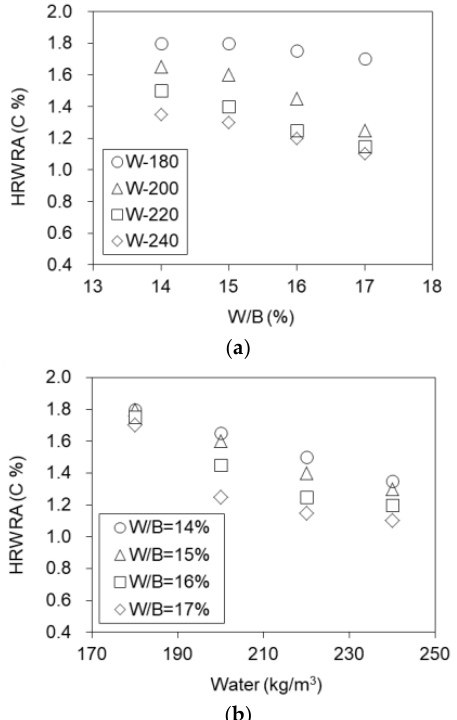
Figure 10. Chemical admixture amount. ( a ) W/B — HRWRA. ( b ) Water — HRWRA.